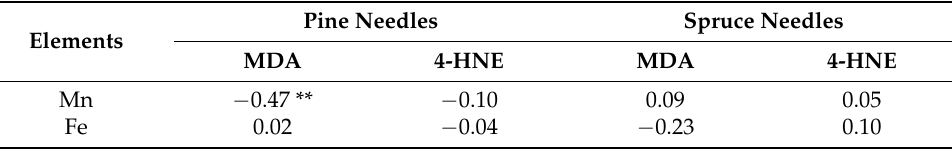
Table 3. Pearson’s correlation coefficients ( r ) between the contents of certain elements and lipid peroxidation